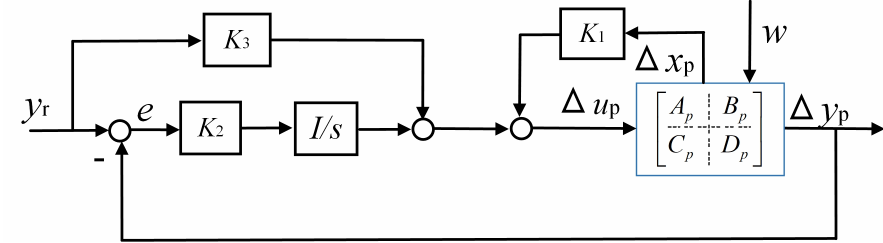
Figure 2. Diagram of output tracking control with a constant h